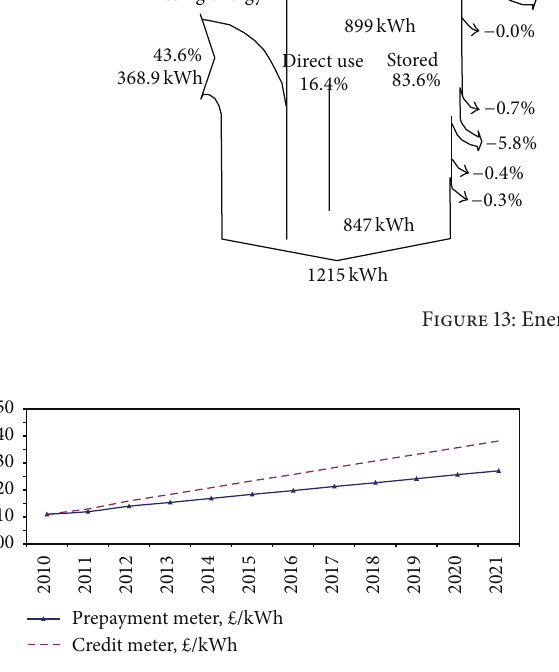
Figure 14: Projected NAWEC utility prices